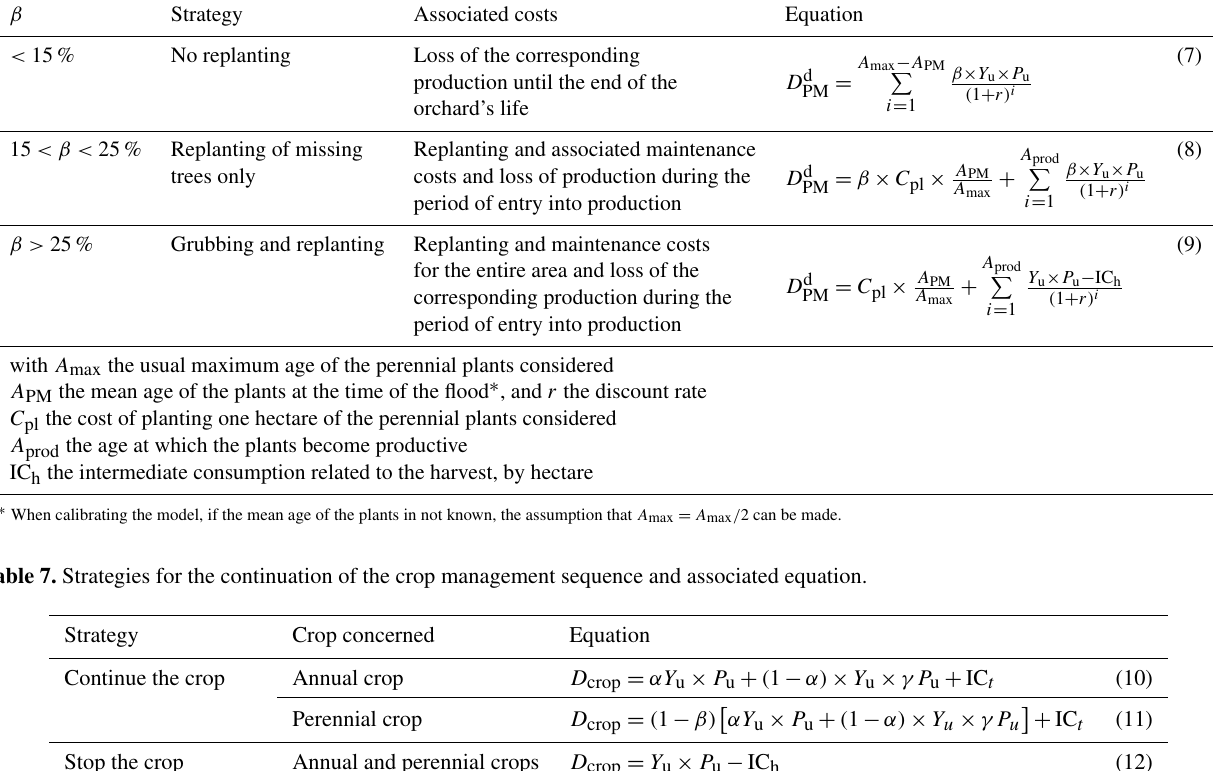
Table 6. Farmers’ strategy for replantation as a function of mortality of plant material ( β ) for the case of arboriculture. β Strategy Associated costs